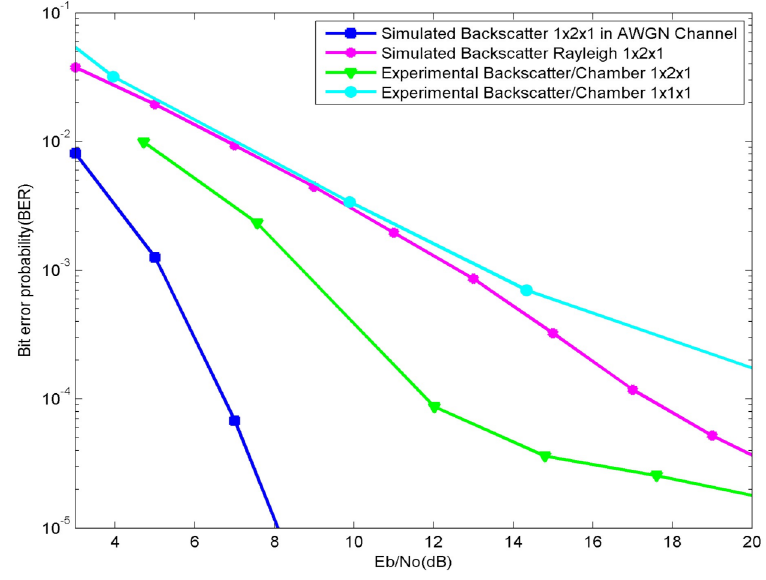
Figure 10. Plot of the experimental and simulated BER results of a 1 × 2 × 1 system vs. a 1 × 1 × 1 system as compared with the AWGN and Rayleigh.